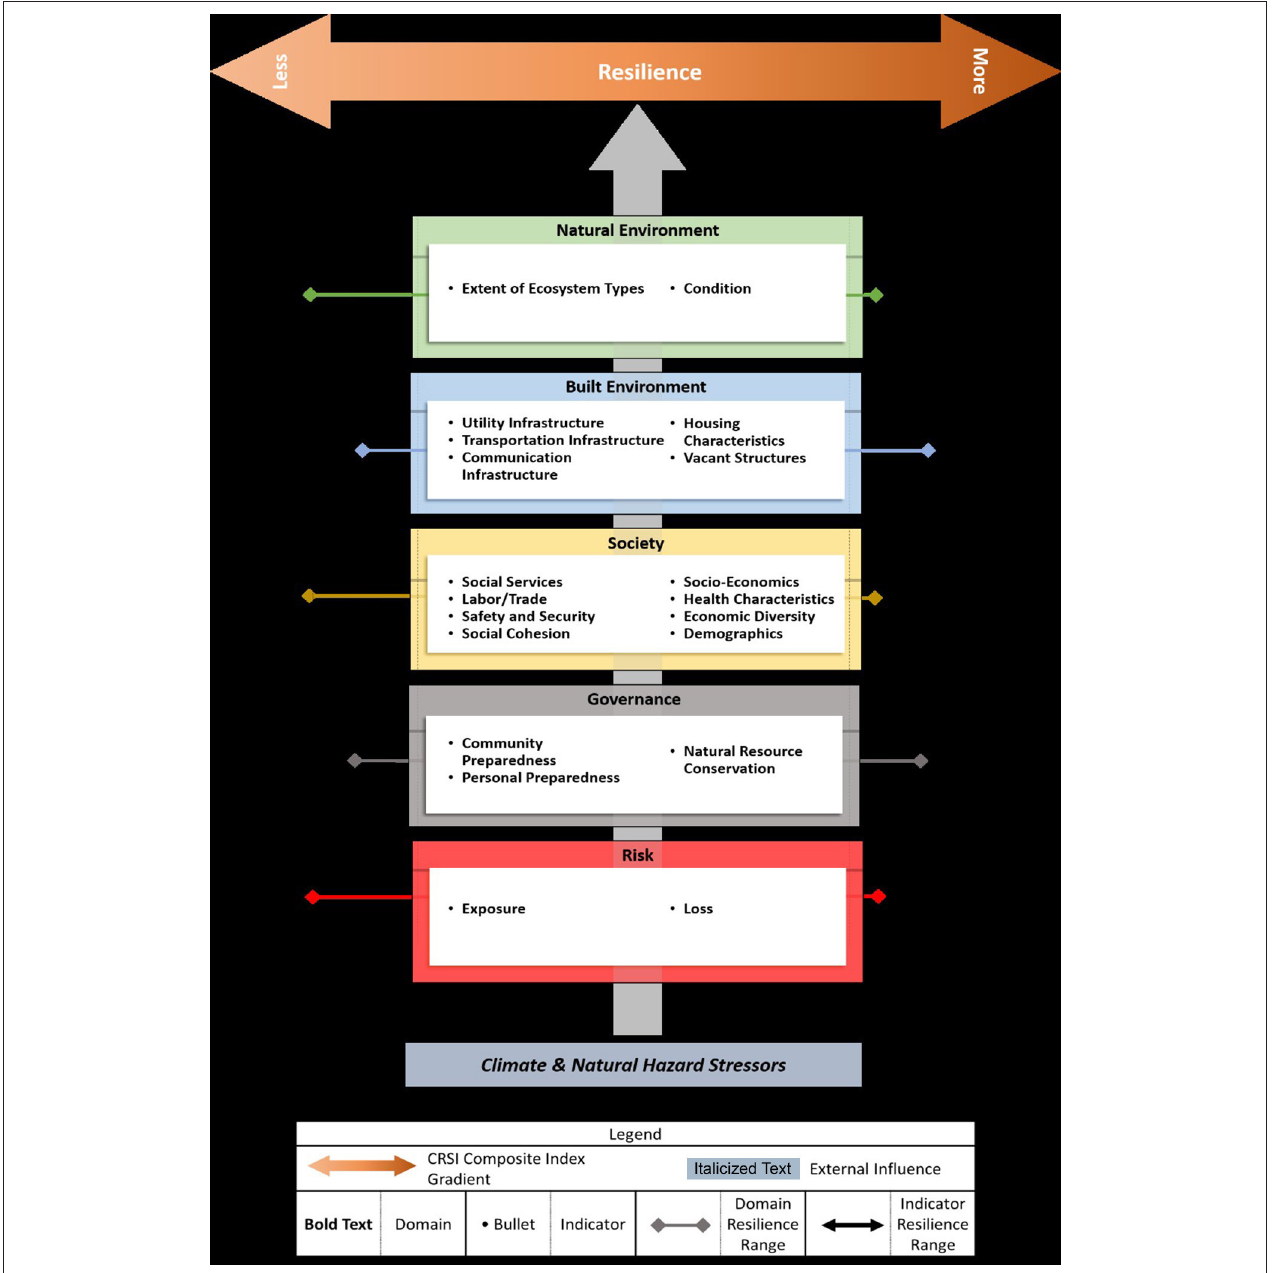
FIGURE 1 | Final CRSI conceptual framework. Arrows projected from boxes to the left and right represent hypothetical increases and decreases in ranges for indicators (black arrows) and domains (colored